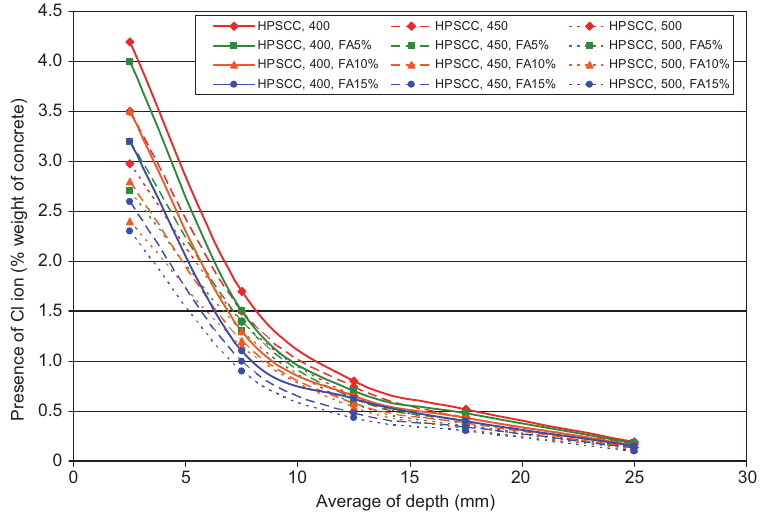
Figure 10 Percentage of chloride ion by depth of the concrete